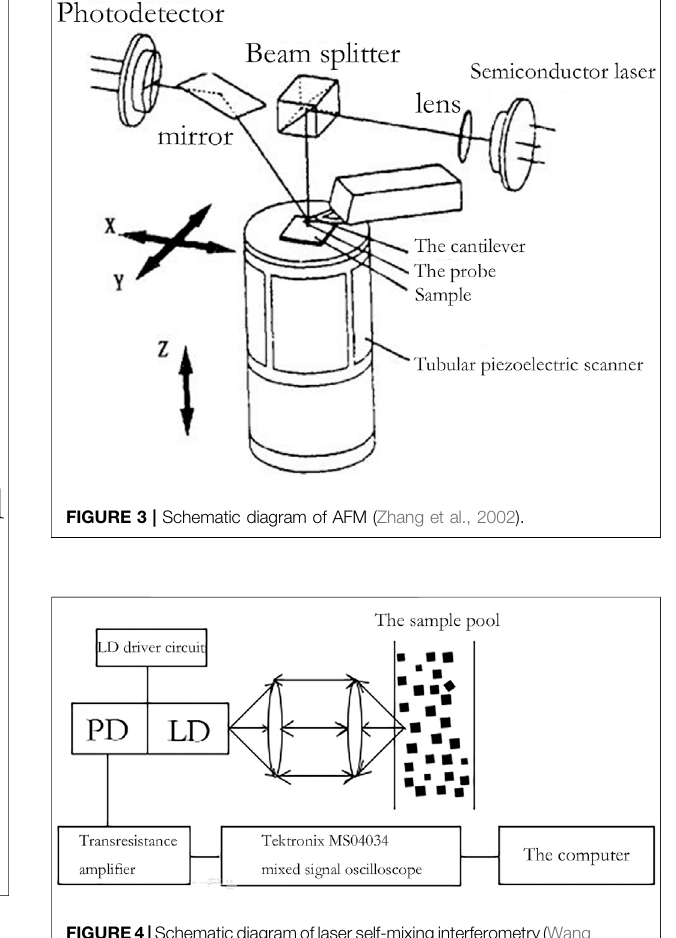
FIGURE4| Schematicdiagramoflaserself-mixinginterferometry(Wang and Shen,